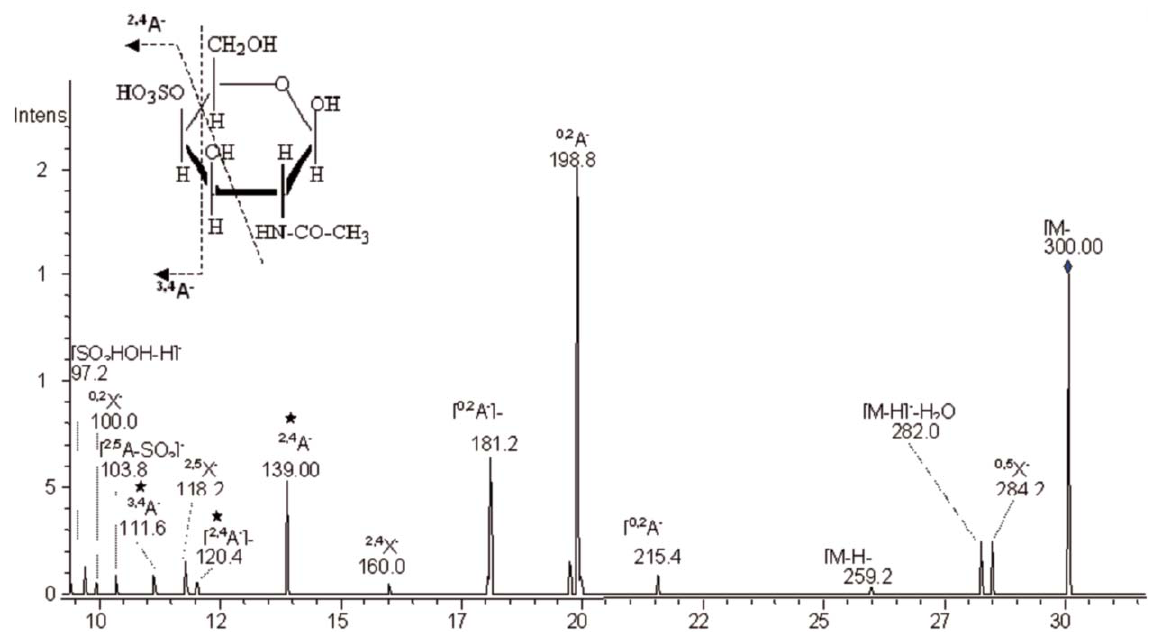
Figure 7. Fully automated chip (-) nanoESI HCT CID MS 3 of the singly deprotonated fragment ion detected in spectrum in Fig. 6 at m/z 300.00 and assigned according to mass calculation a composition of monosulfated GalNAc - . Conditions and symbols are as in Fig.